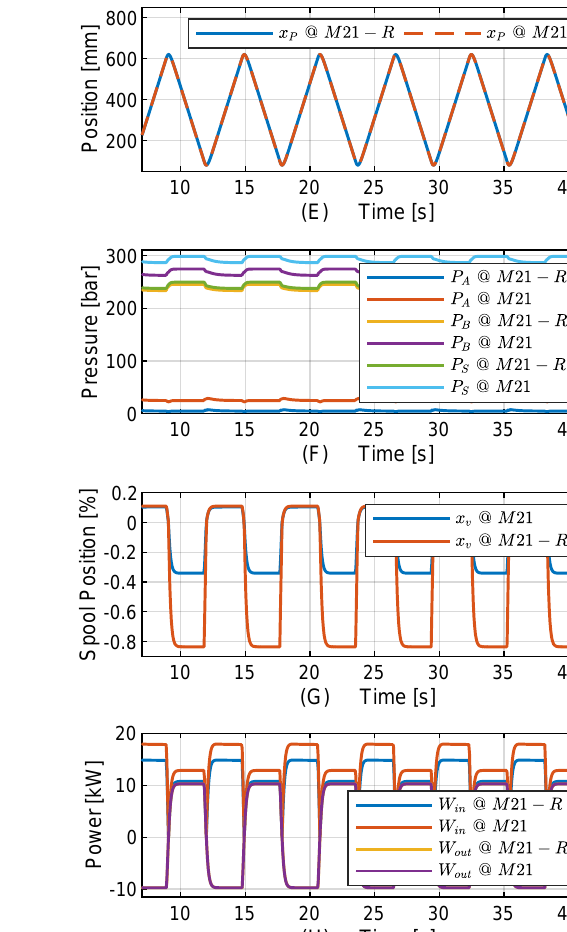
Figure 12. Simulation results for the VCD and VCD-R drive architectures. ( A – D ) Depict the results for M25, M25-R, and ( E – H ) depict the results for M21,